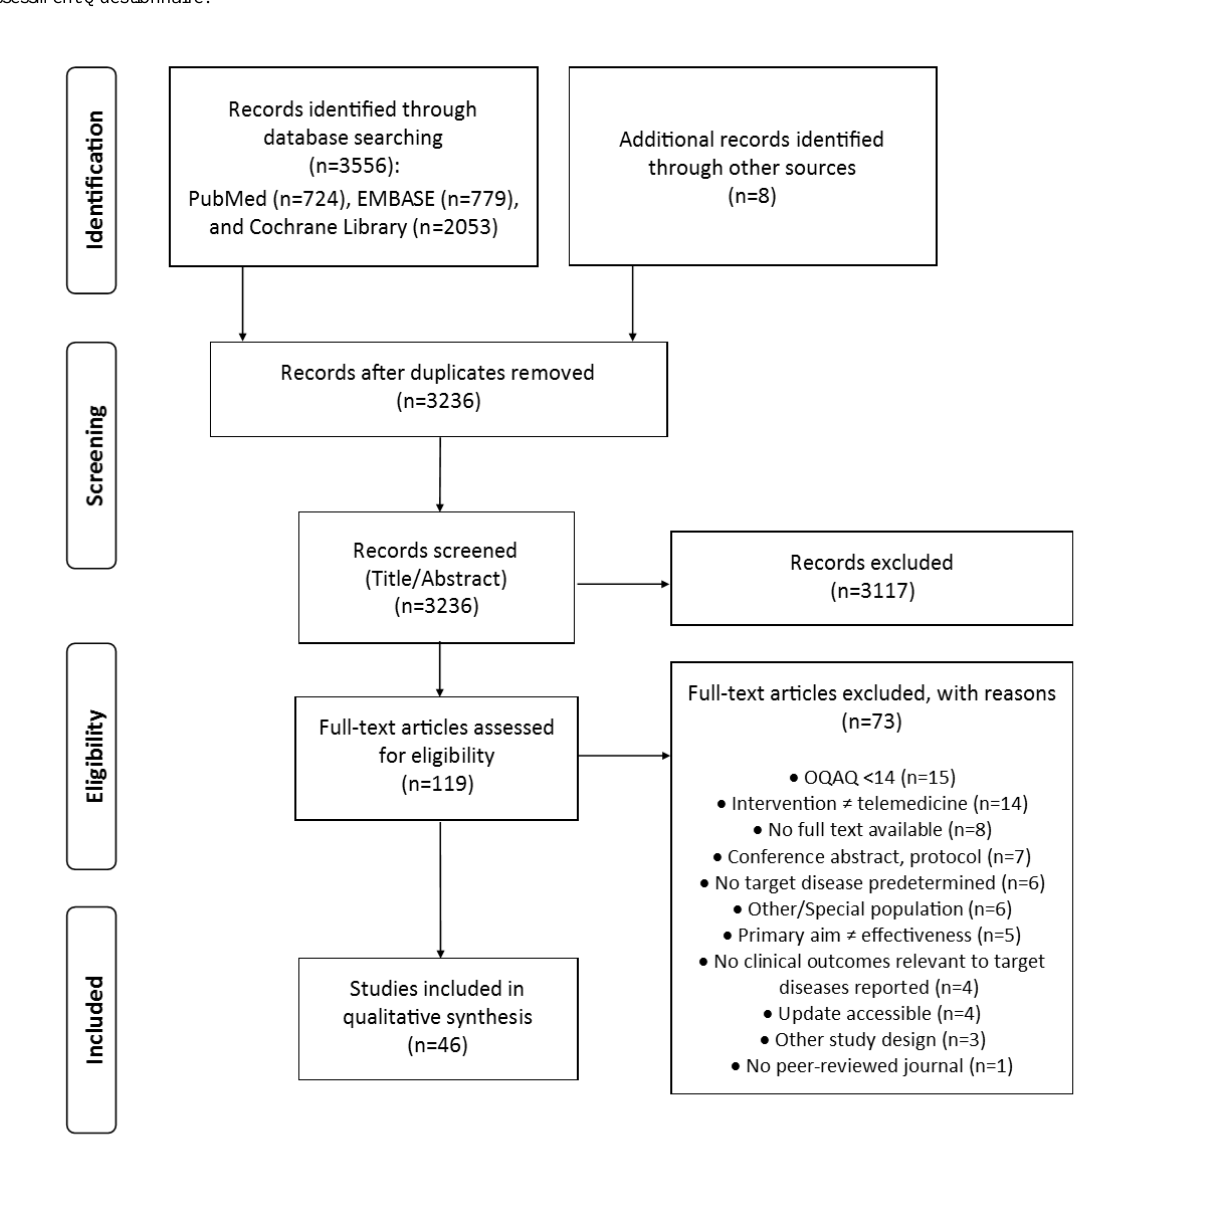
Figure 1. Preferred Reporting Items for Systematic Reviews and Meta-analyses flowchart of the study selection process. OQAQ: Overview Quality Assessment